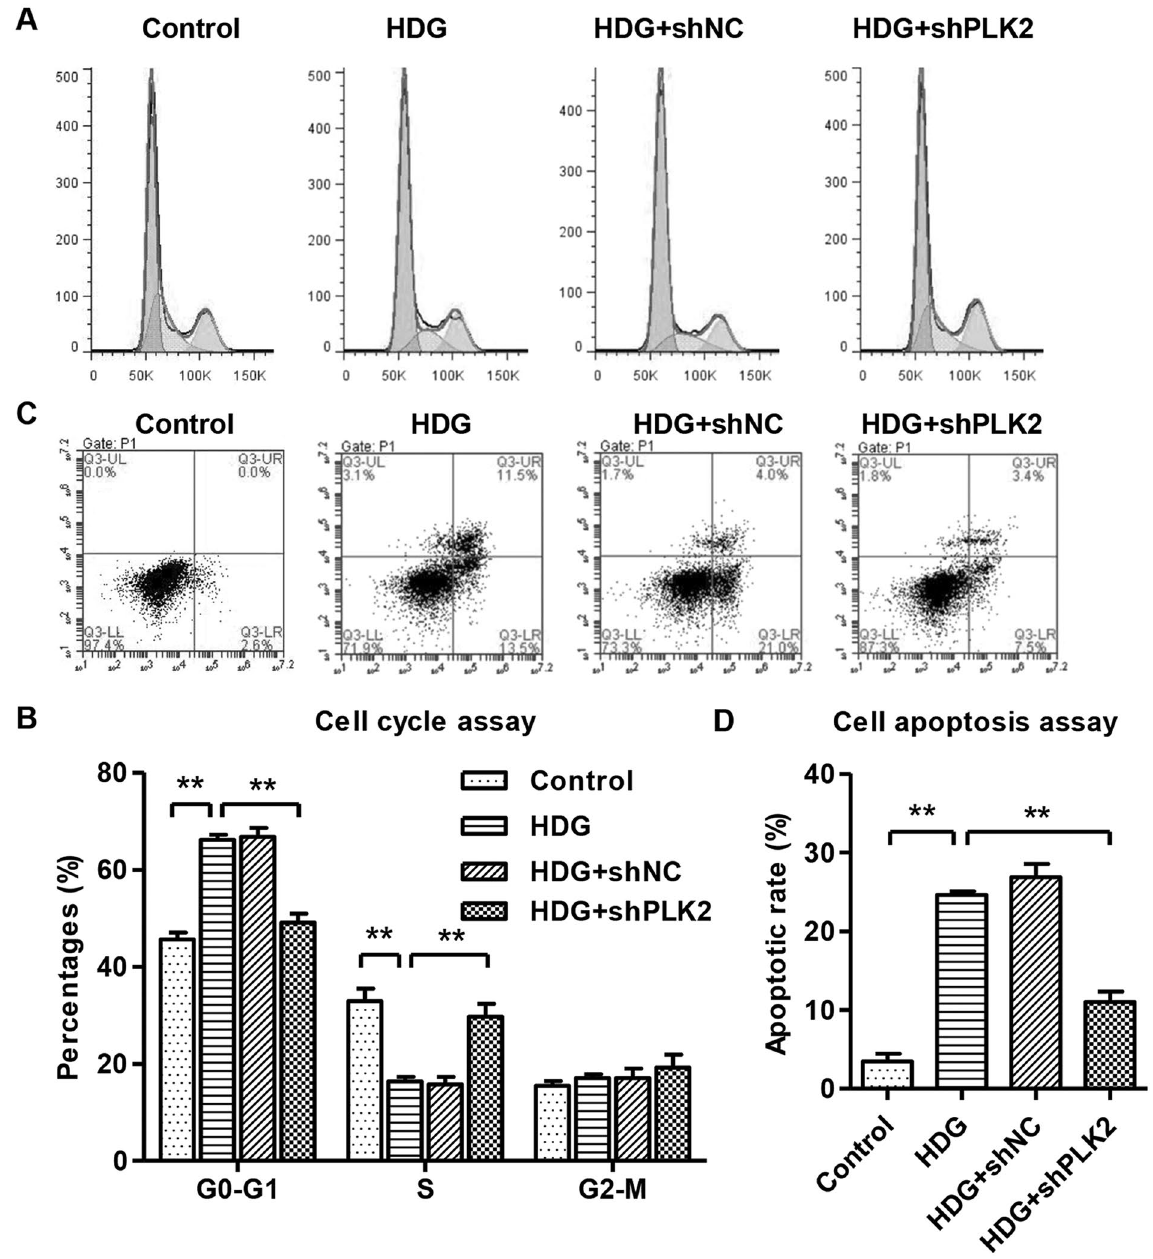
Figure 3. Knocking down PLK2 promoted S-phase entry and decreased apoptosis in mouse podocytes, reversing HDG effects. Podocytes were treated with 30 mM HDG for 12 h. ( A,B ) Cell cycle was measured by propidium iodide (PI) using flow cytometry analysis. ( C,D ) Cell apoptosis was measured by annexin V-fluorescein isothiocyanate (FITC) and PI, using flow cytometry. HDG induced G1 arrest and increased cell apoptosis, which were reversed by PLK2 knockdown. ** P <